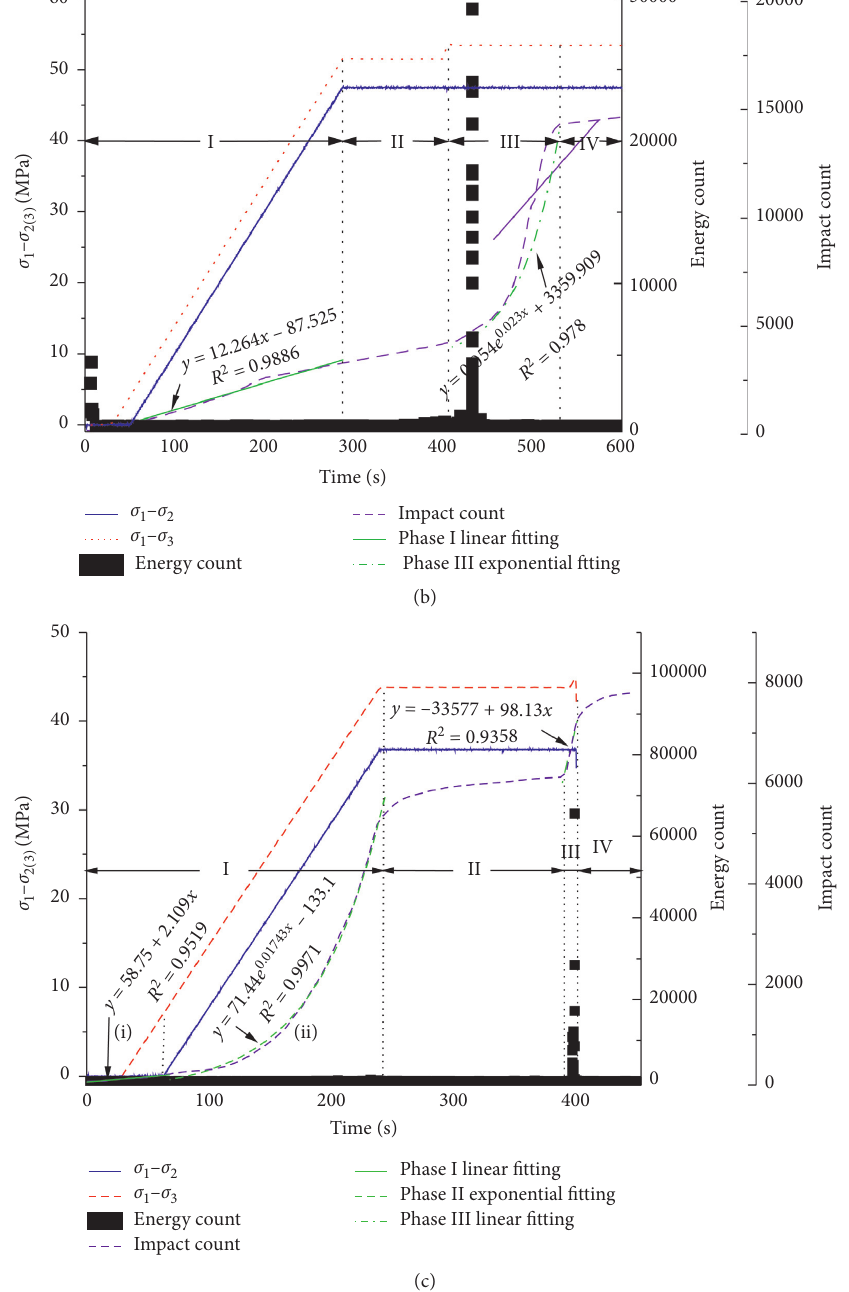
Figure 6: True triaxial unloading test of stress difference-AE curve. (a) Intermediate principal stress is 3 MPa. (b) Intermediate principal stress is 6MPa. (c) Intermediate principal stress is